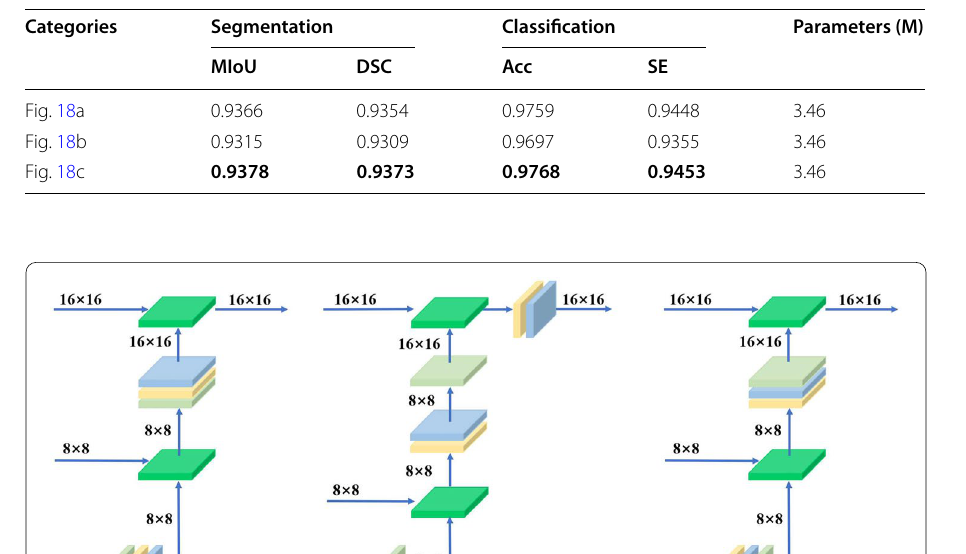
Table 5 Quantitative results on segmentation and classification by different arrangements of feature fusion in HR-MPF